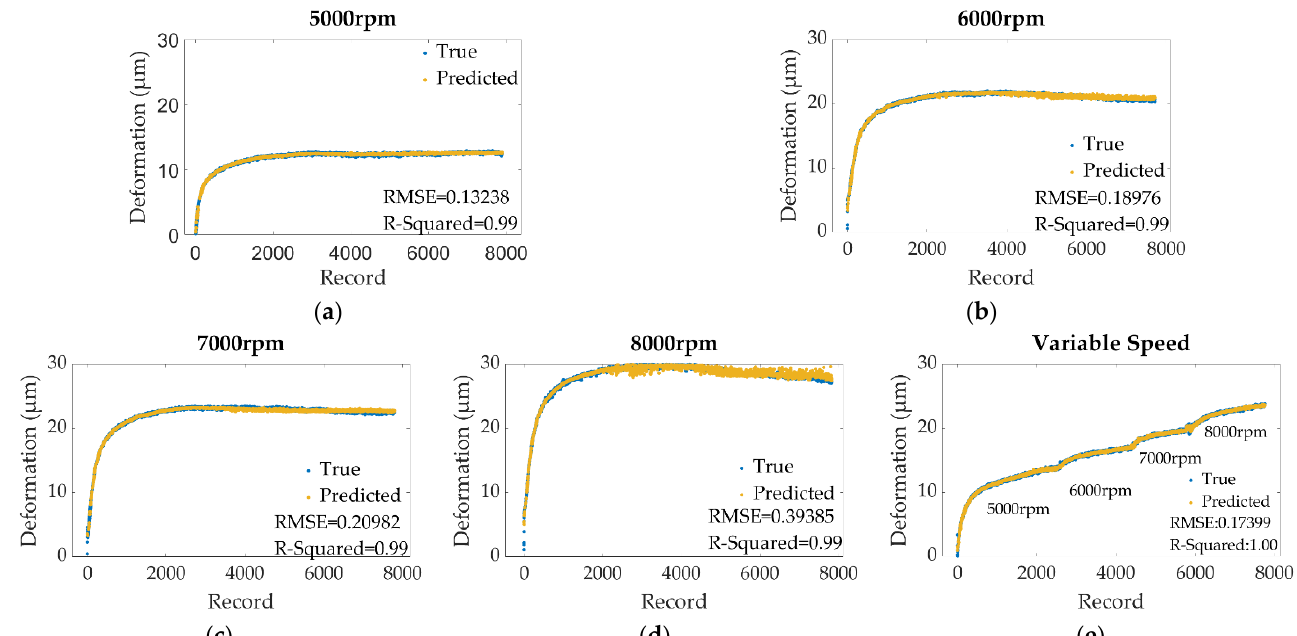
Figure 7. The self-validation of the thermal error model trained by Gaussian process regression under the rotational speed of ( a ) 5000 rpm; ( b ) 6000 rpm; ( c ) 7000 rpm; ( d ) 8000 rpm; ( e ) variable speed.